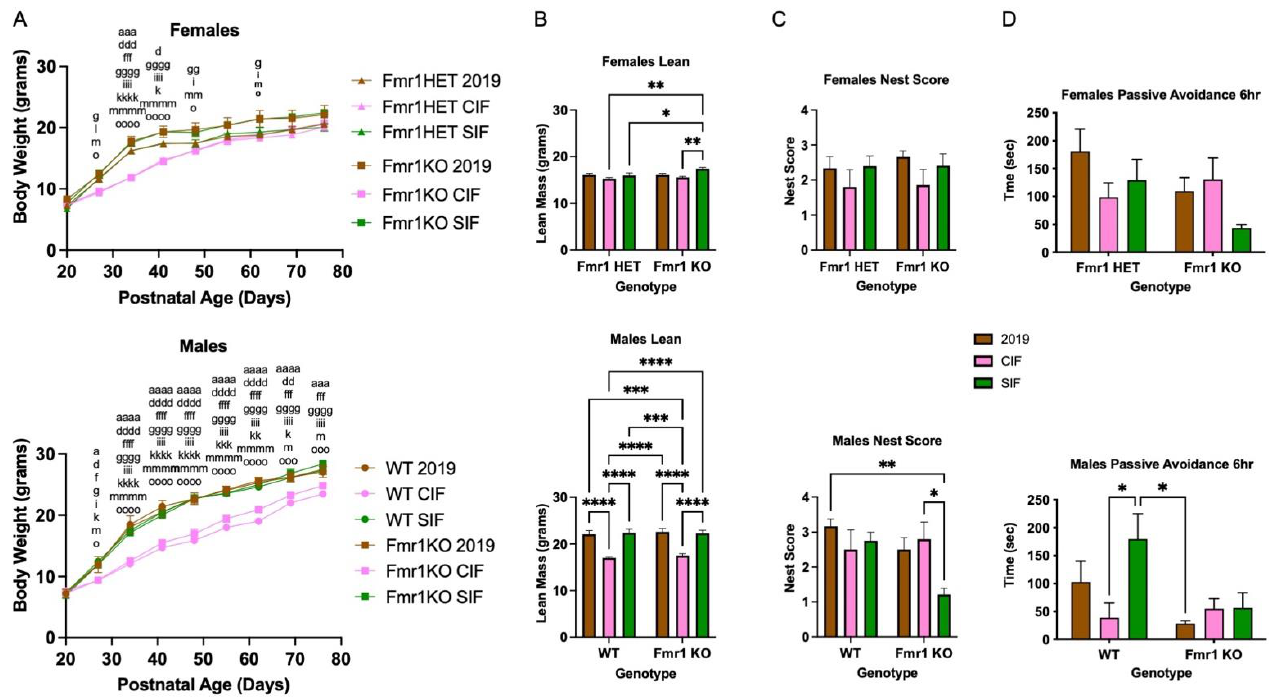
Figure 2. Body weight and behavior of adolescent WT and Fmr1 KO male mice in response to cow milk- and soy-based infant formula diets after 2 months treatment. Fmr1 HET females were bred and maintained on Teklad2019 (grain-based but low phytoestrogen levels) diet throughout gestation and lactation. Female Fmr1 HET and Fmr1 KO and male WT and Fmr1 KO pups were weaned at P20 and randomized to diets (Teklad 2019, CIF, SIF). ( A ) The mice were weighed once per week for 2 months. Female cohorts included Fmr1 HET /Teklad 2019 ( n = 4), Fmr1 HET /CIF ( n = 5), Fmr1 HET /SIF ( n = 6), Fmr1 KO /Teklad 2019 ( n = 7), Fmr1 KO /CIF ( n = 7) and Fmr1 KO /SIF ( n = 6). Statistics were determined by 2-way mixed effects model ANOVA: time F(8230) = 1413, p < 0.0001; genotype/diet F(5,29) = 5.122, p = 0.0017; time x genotype/diet F(40,230) = 8.714, p < 0.0001. Male cohorts included the following: WT/Teklad 2019 ( n = 6), WT/CIF ( n = 6), WT//SIF ( n = 4), Fmr1 KO /Teklad 2019 ( n = 5), Fmr1 KO /CIF ( n = 5) and Fmr1 KO /SIF ( n = 7). Statistics were determined by 2-way mixed-effects model ANOVA: time F(8216) = 2550, p < 0.0001; genotype/diet F(5,27) = 16.78, p < 0.0001; time x genotype/diet F(40,216) = 13.34, p < 0.0001. Tukey’s multiple comparison tests are denoted by p < 0.05 ( x ), p < 0.01 ( xx ), p < 0.001 ( xxx ), and p < 0.0001 ( xxxx ) where females x = a for Fmr1 HET Teklad 2019 versus Fmr1 HET CIF, x = b for Fmr1 HET Teklad 2019 versus Fmr1 HET SIF, x = c for Fmr1 HET Teklad 2019 versus Fmr1 KO 2019, x = d for Fmr1 HET Teklad 2019 versus Fmr1 KO CIF, x = e for Fmr1 HET Teklad 2019 versus Fmr1 KO SIF, x = f for Fmr1 HET CIF versus Fmr1 HET SIF, x = g for Fmr1 HET CIF versus Fmr1 KO 2019, x = h for Fmr1 HET CIF versus Fmr1 KO CIF, x = i for Fmr1 HET CIF versus Fmr1 KO SIF, x = j for Fmr1 HET SIF versus Fmr1 KO 2019, x = k for Fmr1 HET SIF versus Fmr1 KO CIF, x = l for Fmr1 HET SIF versus Fmr1 KO SIF, x = m for Fmr1 KO Teklad 2019 versus Fmr1 KO CIF, x = n for Fmr1 KO Teklad 2019 versus Fmr1 KO SIF, and x = o for Fmr1 KO CIF versus Fmr1 KO SIF, and males x = a for WT Teklad 2019 versus WT CIF, x = b for WT Teklad 2019 versus WT SIF, x = c for WT Teklad 2019 versus Fmr1 KO 2019, x = d for WT Teklad 2019 versus Fmr1 KO CIF, x = e for WT Teklad 2019 versus Fmr1 KO SIF, x = f for WT CIF versus WT SIF, x = g for WT CIF versus Fmr1 KO 2019, x = h for WT CIF versus Fmr1 KO CIF, x = i for WT CIF versus Fmr1 KO SIF, x = j for WT SIF versus Fmr1 KO 2019, x = k for WT SIF versus Fmr1 KO CIF, x = l for WT SIF versus Fmr1 KO SIF, x = m for Fmr1 KO Teklad 2019 versus Fmr1 KO CIF, x = n for Fmr1 KO Teklad 2019 versus Fmr1 KO SIF, and x = o for Fmr1 KO CIF versus Fmr1 KO SIF. ( B ) EchoMRI measurement of lean body mass. Female cohorts include Fmr1 HET /Teklad 2019 ( n = 4), Fmr1 HET /CIF ( n = 5), Fmr1 HET /SIF ( n = 6), Fmr1 KO /Teklad 2019 ( n = 6), Fmr1 KO /CIF ( n = 7) and Fmr1 KO /SIF ( n = 6). Statistics were determined by two-way ANOVA: interaction F(2,28) = 2.702, p = 0.085; genotype F(1,28) = 4.410, p = 0.045; diet F(2,28) = 7.438, p = 0.0026. Male cohorts include WT/Teklad 2019 ( n = 6), WT/CIF ( n = 6), WT/SIF ( n = 4),